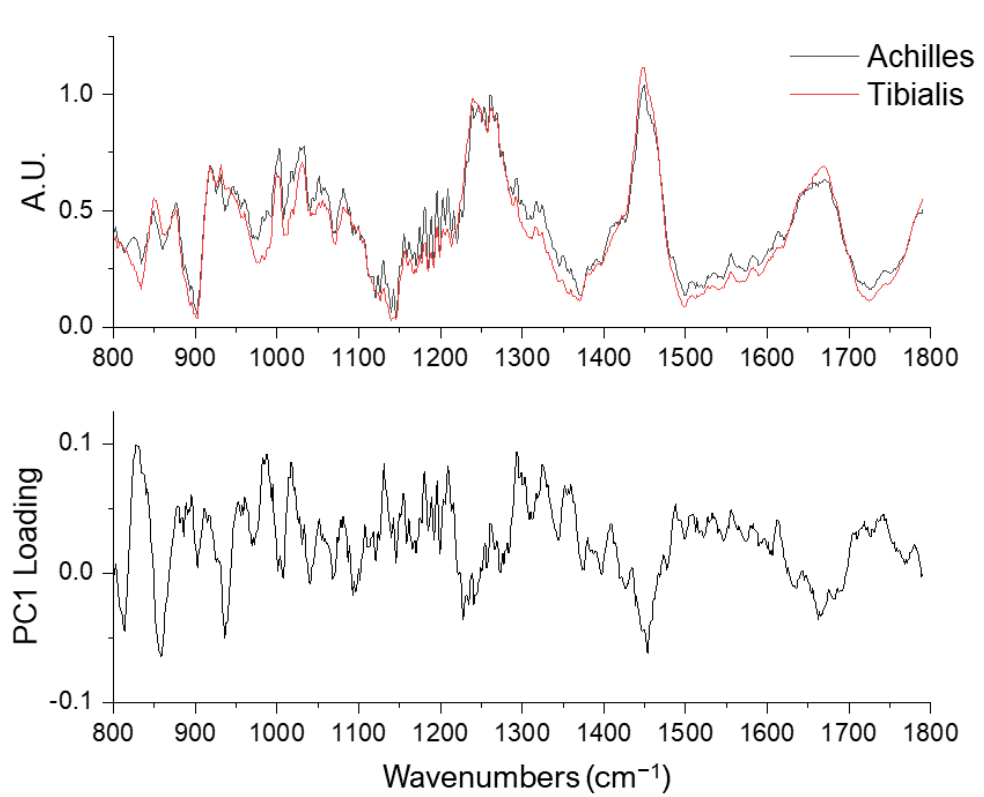
Figure 5. Averaged Raman spectra of Achilles (n = 80, black lines, upper row) and tibialis anterior tendons (n = 80, red lines) and the PC1 loading (lower row). Table 2. Raman band intensities between Achilles tendon (n = 80) and tibialis anterior tendon (n = 80).